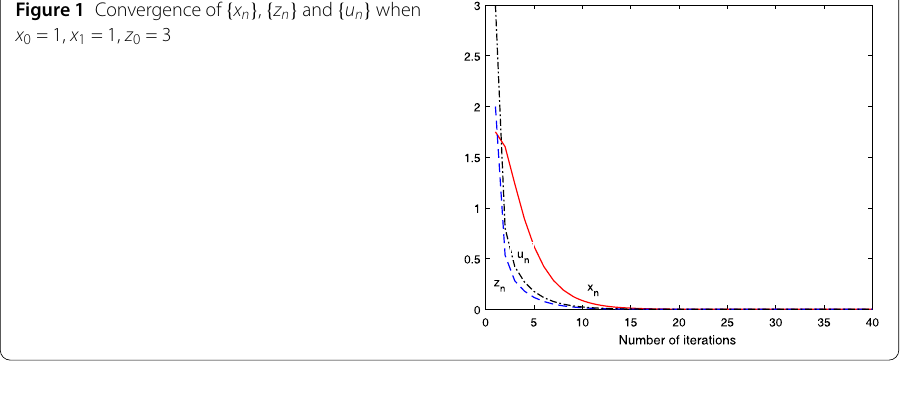
Figure 2 Convergence of { x n } , { z n } and { u n } when x 0 = –1, x 1 = –2, z 0 =